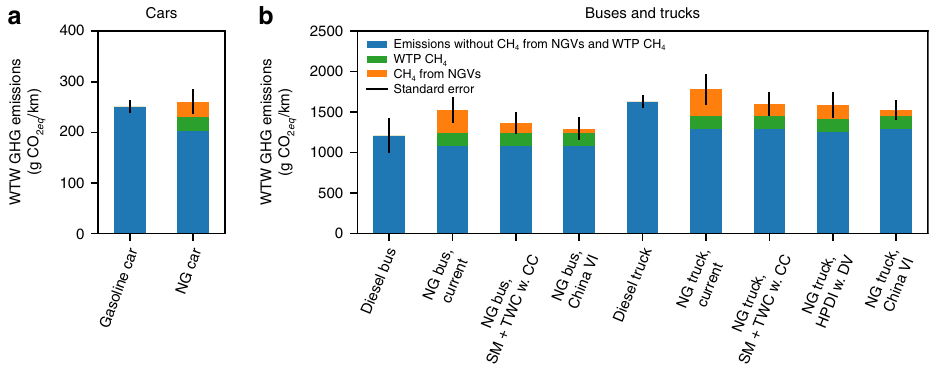
Fig. 3 Well-to-wheels GHG emissions of vehicles powered by gasoline, diesel, and NG in China. Panels a and b show the well-to-wheels GHG emissions for light- and heavy-duty vehicles, respectively, in China. Blue bars show the WTW GHG emissions without CH 4 contribution. Green and orange bars are the CO 2 equivalents of WTP CH 4 emissions and CH 4 emissions from NGVs (a GWP of 30 over a time-scale of 100 years is used for CH 4 from fossil fuel consumption according to IPCC AR5) 12 . For cars and buses, NGVs may not bring GHG emission mitigation. NG trucks that meet China VI standard have lower GHG emissions compared to diesel trucks. The black error bars indicate high and low estimates derived using error propagation of uncertainties of multiple input parameters (e.g., life-cycle GHG emissions, CH 4 emission factors, and fuel consumptions). Uncertainty estimates (standard deviation, S.D.) of individual parameters are listed in Supplementary Tables 1, 6, 7, and 11. Source data are provided as a Source Data fi